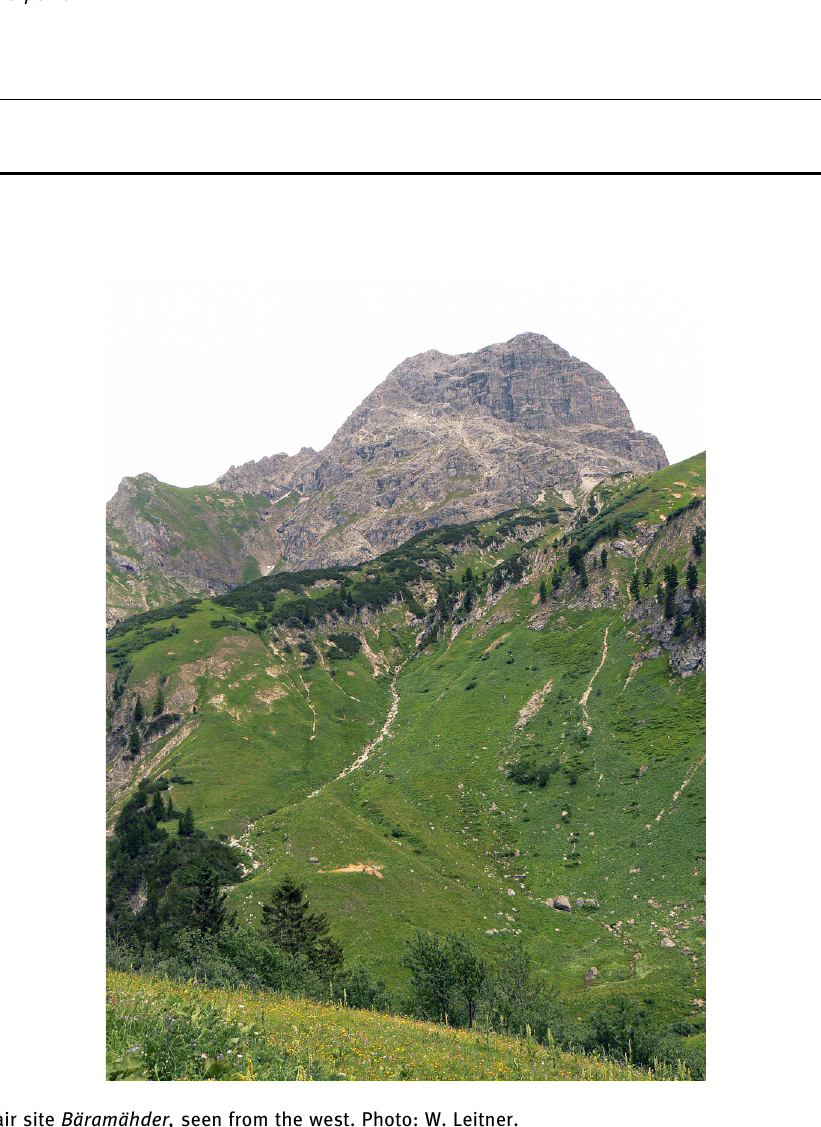
Figure 9: Open - air site Bäramähder, seen from the west. Photo: W.